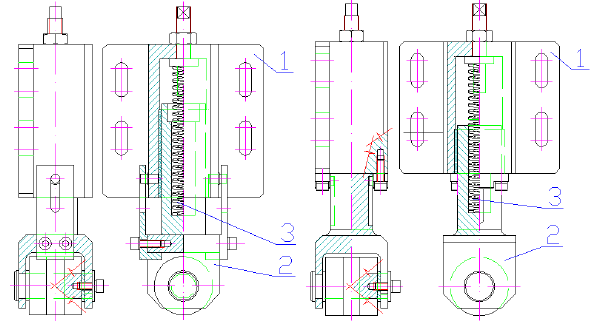
Figure 1: Pallet brake